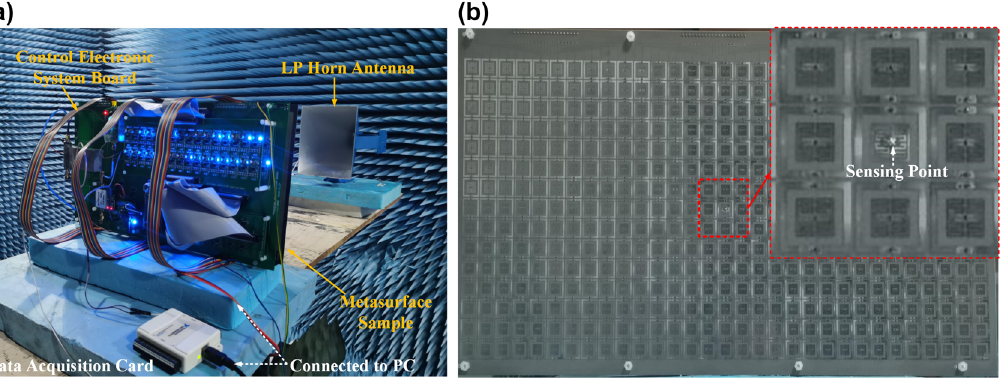
Figure 6: Experimental